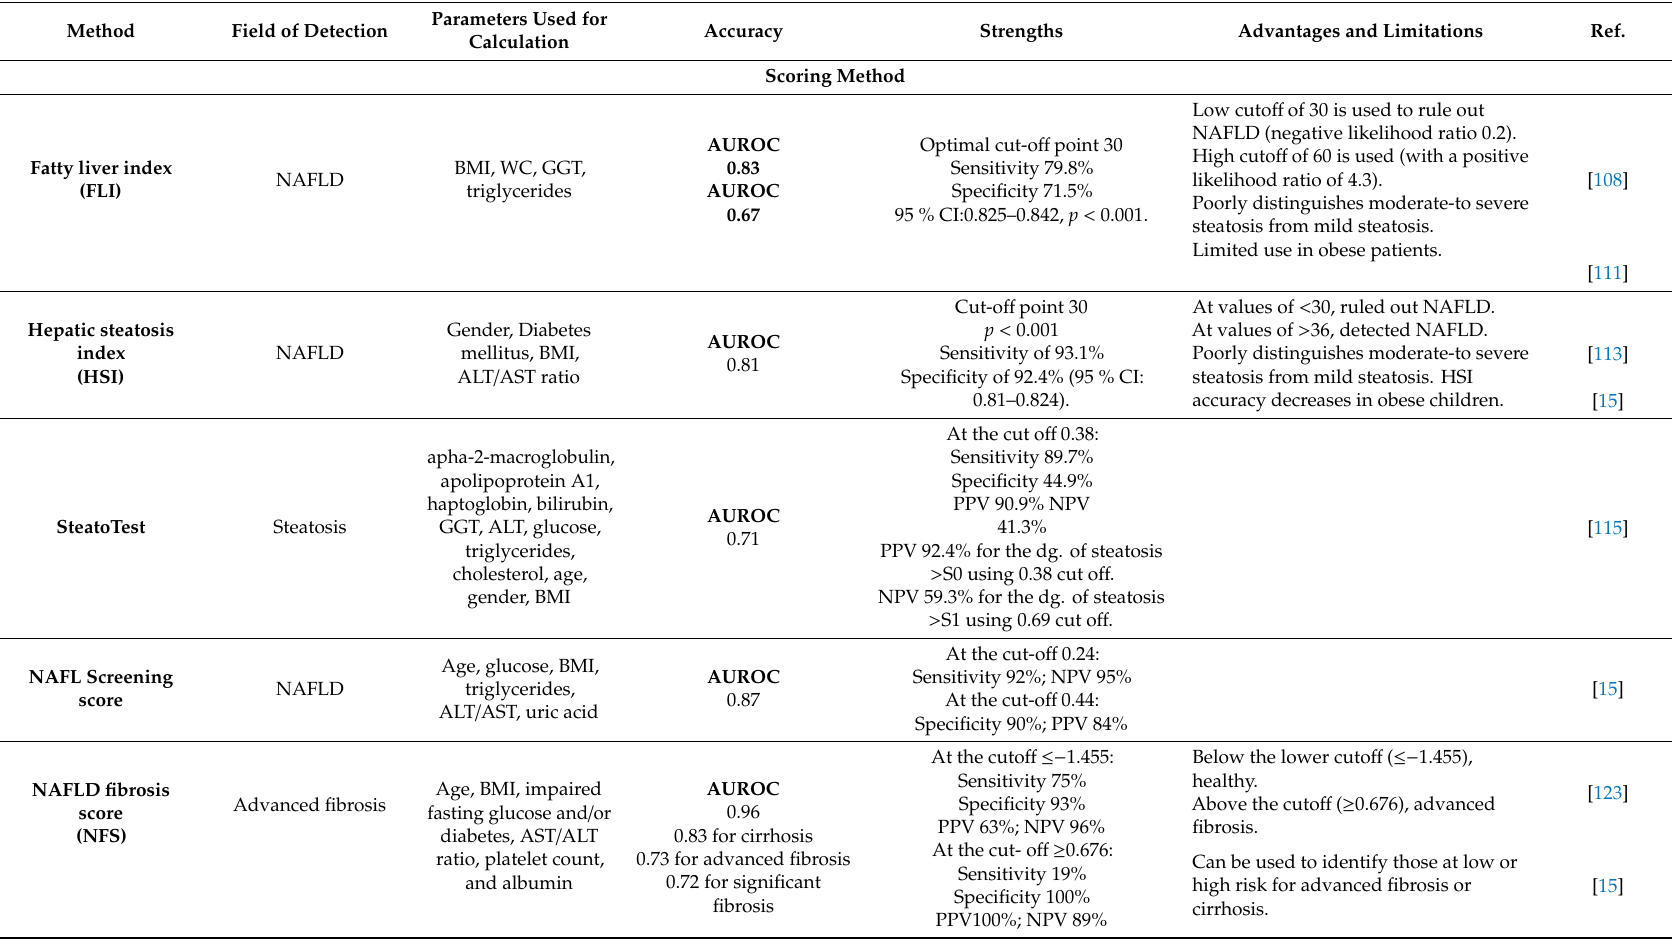
Table 3. Values of AUROC for most accurate non-invasive scoring